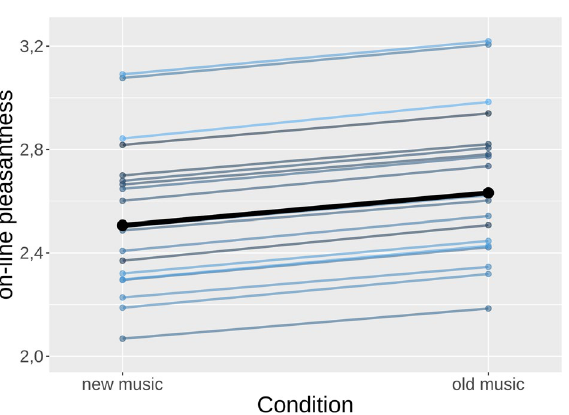
Figure 3. Time-weighted self-reported pleasantness in the two familiarity conditions of the experimental session (new vs old). Thin blue lines represent each participant’s increase. The thick black line represents the group-level increase. Dots represent parameter estimates. Plot generated in R 53 with package ggplot2 54